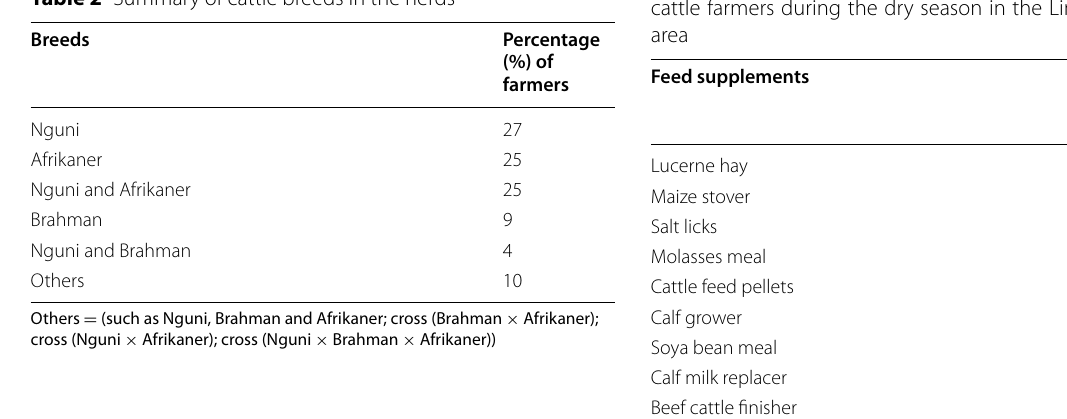
Table 2 Summary of cattle breeds in the herds